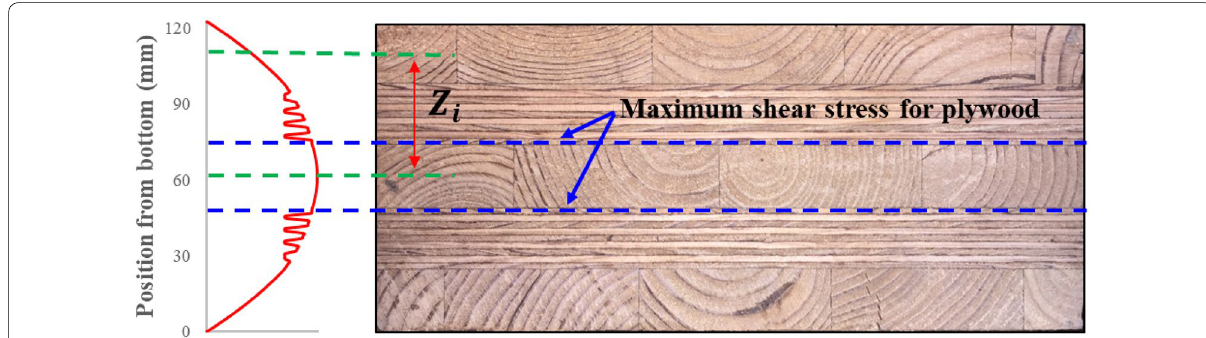
Fig. 4 Shear stress distribution to predict moment capacity of